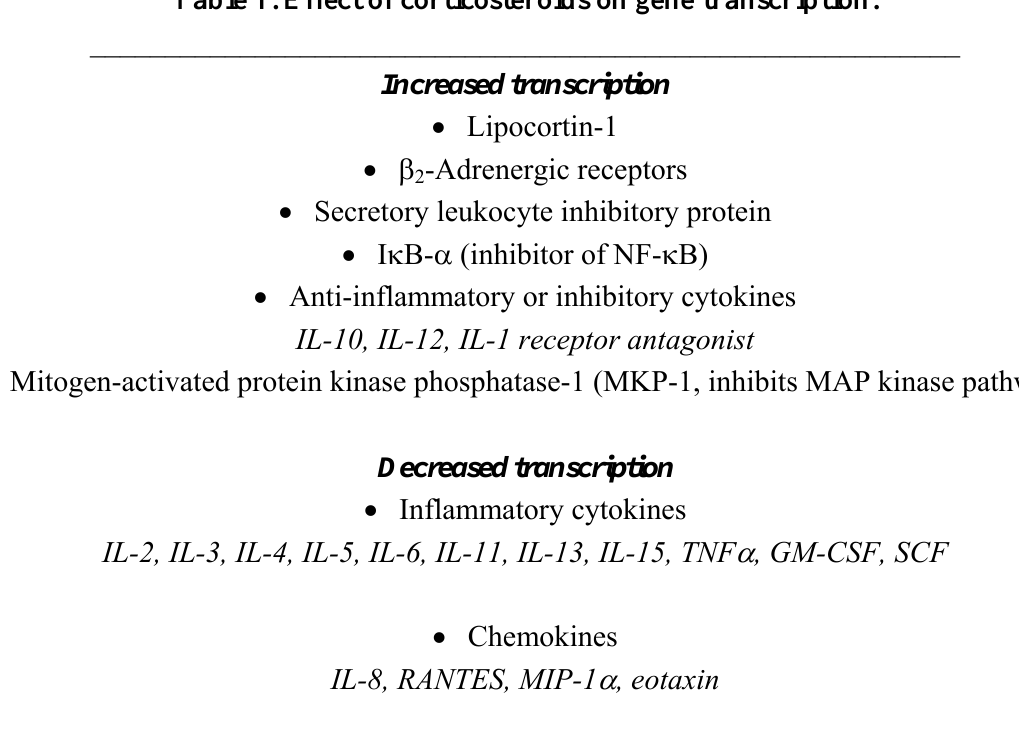
Table 1. Effect of corticosteroids on gene